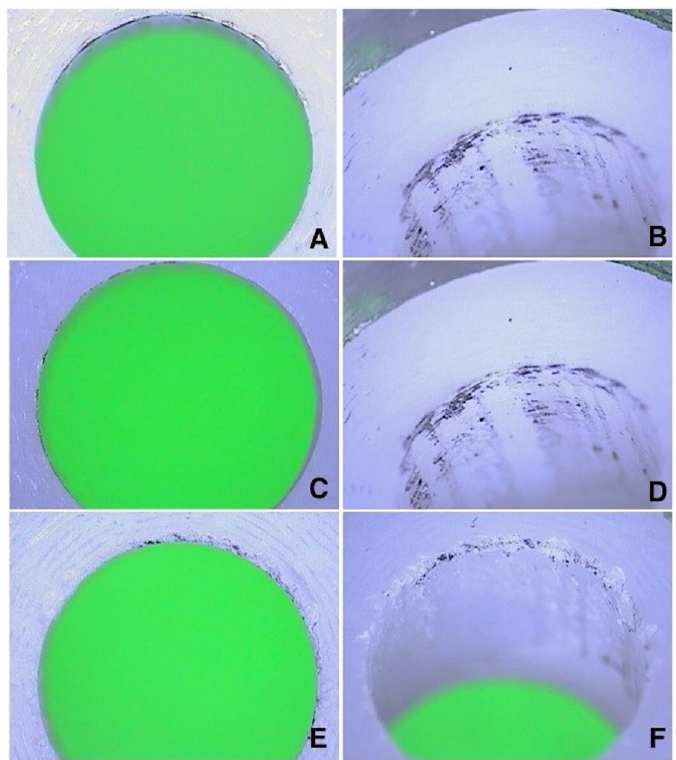
Figure 5. Green background and different wear of zirconia sleeves for the three drill-sleeve distances of ( A , B ) 0.01 mm, ( C , D ) 0.02 mm, and ( E , F ) 0.03 mm was shown via using an EM-2.5D semi-automatic series specification. The 0.03 mm showed more wear among three distances.